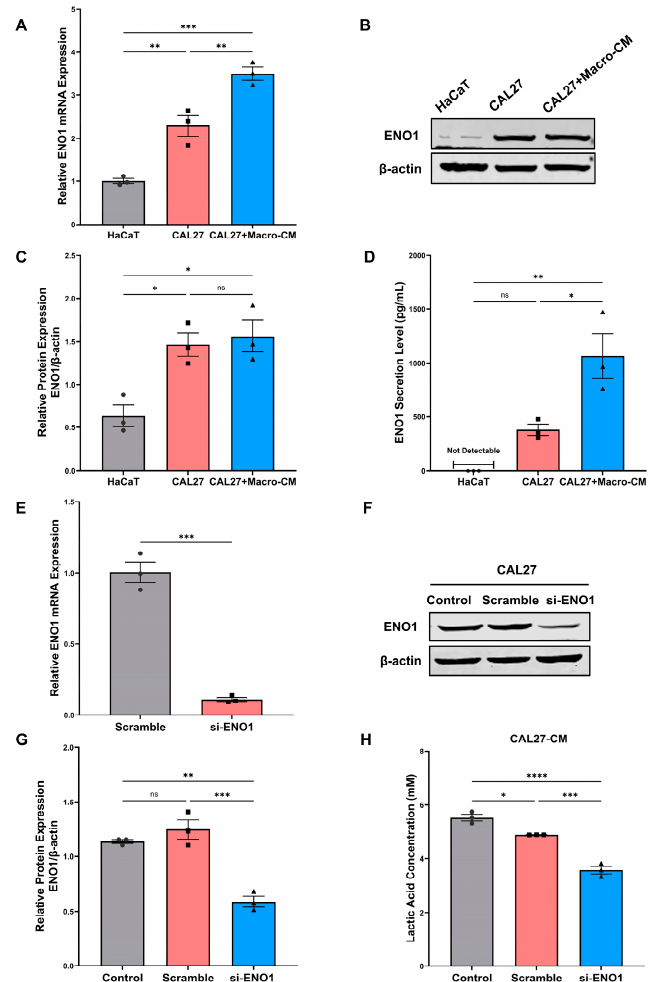
Figure 1. Expression and secretion of ENO1 in tumor cells and its regulation of lactic acid release. ( A ) Relative mRNA expression levels of ENO1 were detected by RT-qPCR in different cell lines. β -actin was used as a reference to normalize the data. ( B , C ) Relative protein expression levels of ENO1 were detected by Western blot. β -actin was used as a reference to normalize the data. ( D ) Protein secretion levels of ENO1 in cell culture supernatant were detected by ELISA. ( E ) The transfection efficiency of ENO1 mRNA expression levels were detected by RT-qPCR (48 h). ( F , G ) The transfection efficiency of ENO1 protein expression levels were detected by Western blot (72 h). ( H ) The lactic acid concentration was determined in the medium of untreated (control), scrambled siRNA and ENO1-siRNA-transfected CAL27 cells. β -actin was used as a reference to normalize the data. All data are displayed as mean ± SEM; n = 3; ns, no significance, * p < 0.05, ** p < 0.01, *** p < 0.001 and **** p < 0.0001. Different symbols (circle/square/triangle) were used to represent the data points of independent biological repeated experiments.